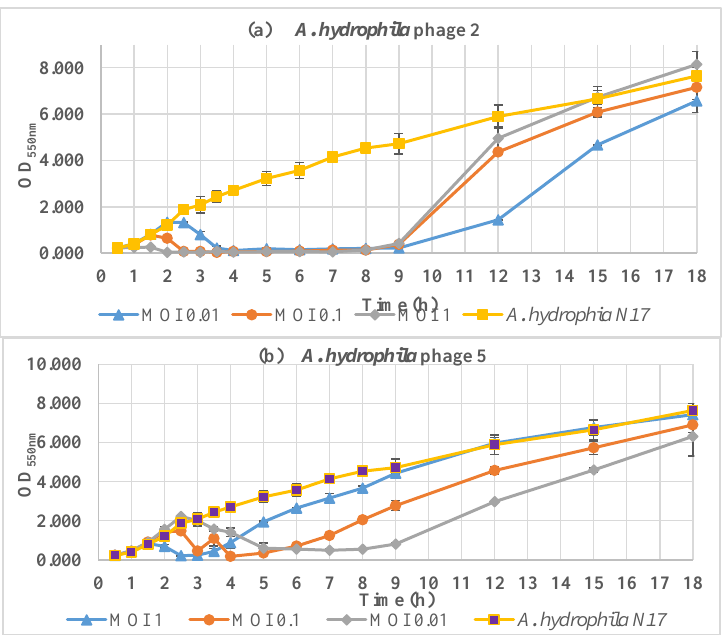
Figure 3. ( a ) Adsorption rate and ( b ) one-step growth curves of  2 .